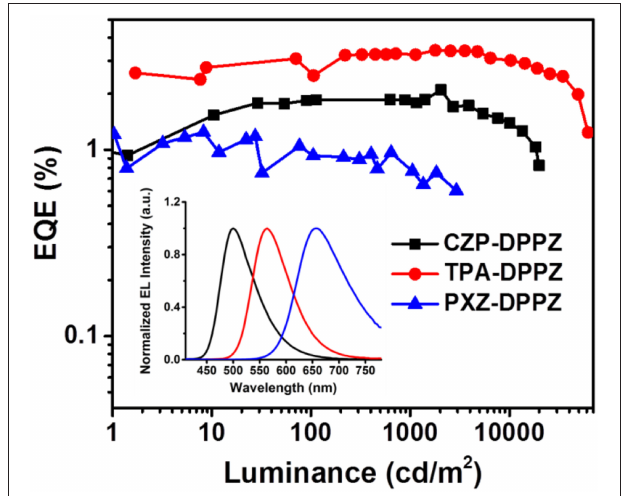
FIGURE 6 | EL spectrum and external quantum efficiency vs. luminance curves of CZP-DPPZ, TPA-DPPZ, and PXZ-DPPZ